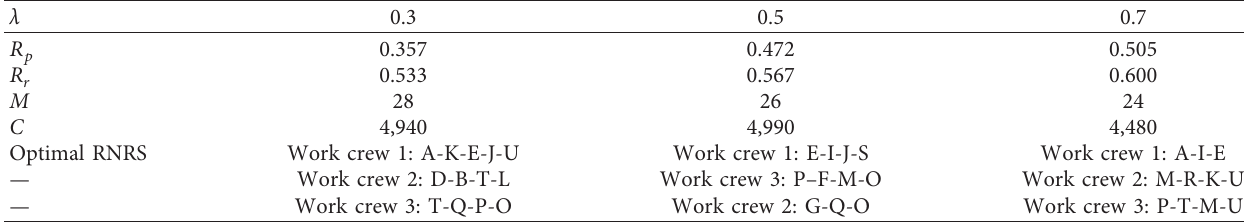
Table 6: Effect of λ on the optimal RNRS.